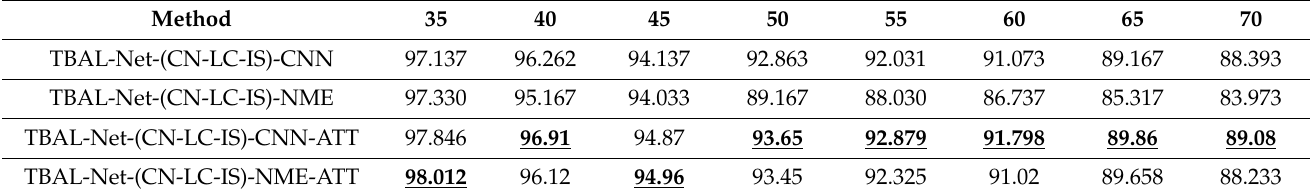
Table 3. Performance of TBAL-Net with/without attention modules on FGVC-Aircraft (Top-1 Accuracy). Method